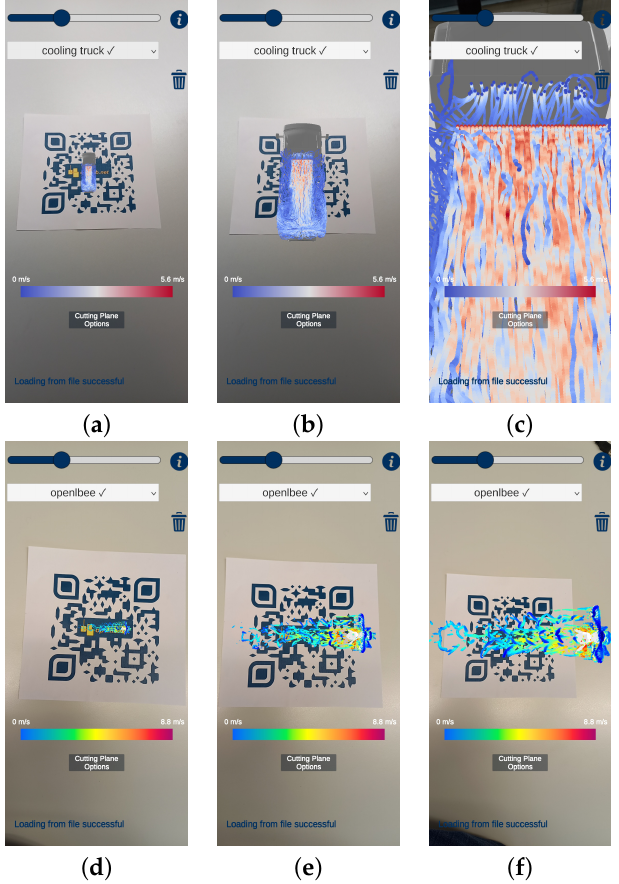
Figure 13. Here, you can see the simulations on the QR code with different zoom. Figure 13a–c shows this on the basis of the cooling truck and Figure 13d–f on the basis of the OlBee. ( a ) Cooling truck zoomed out. ( b ) Cooling truck medium zoom. ( c ) Cooling truck zoomed in. ( d ) OLBee zoomed out. ( e ) OLBee medium zoom. ( f ) OLBee zoomed